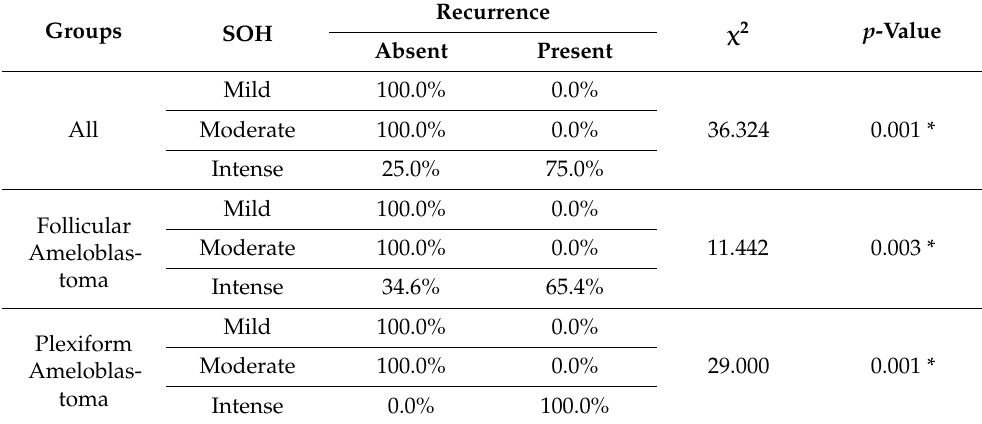
Table 2. Comparison of correlation of SOH with Recurrence of Solid Multicystic Ameloblastoma.